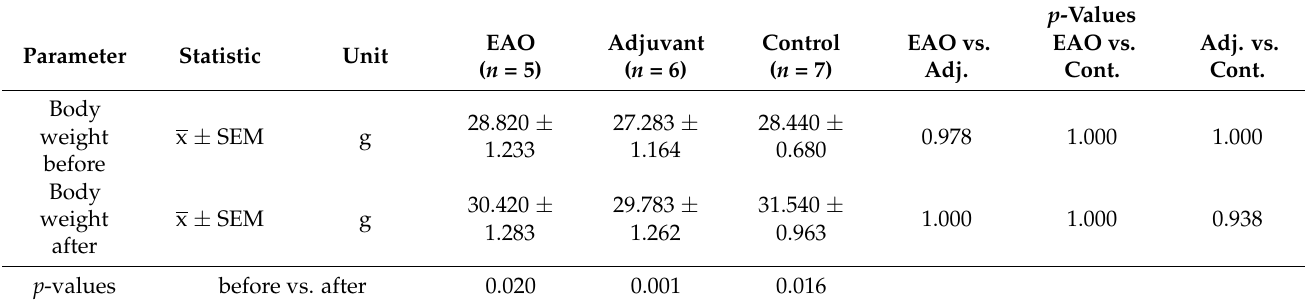
Table 1. Body weights before the first immunization and 50 days after the first